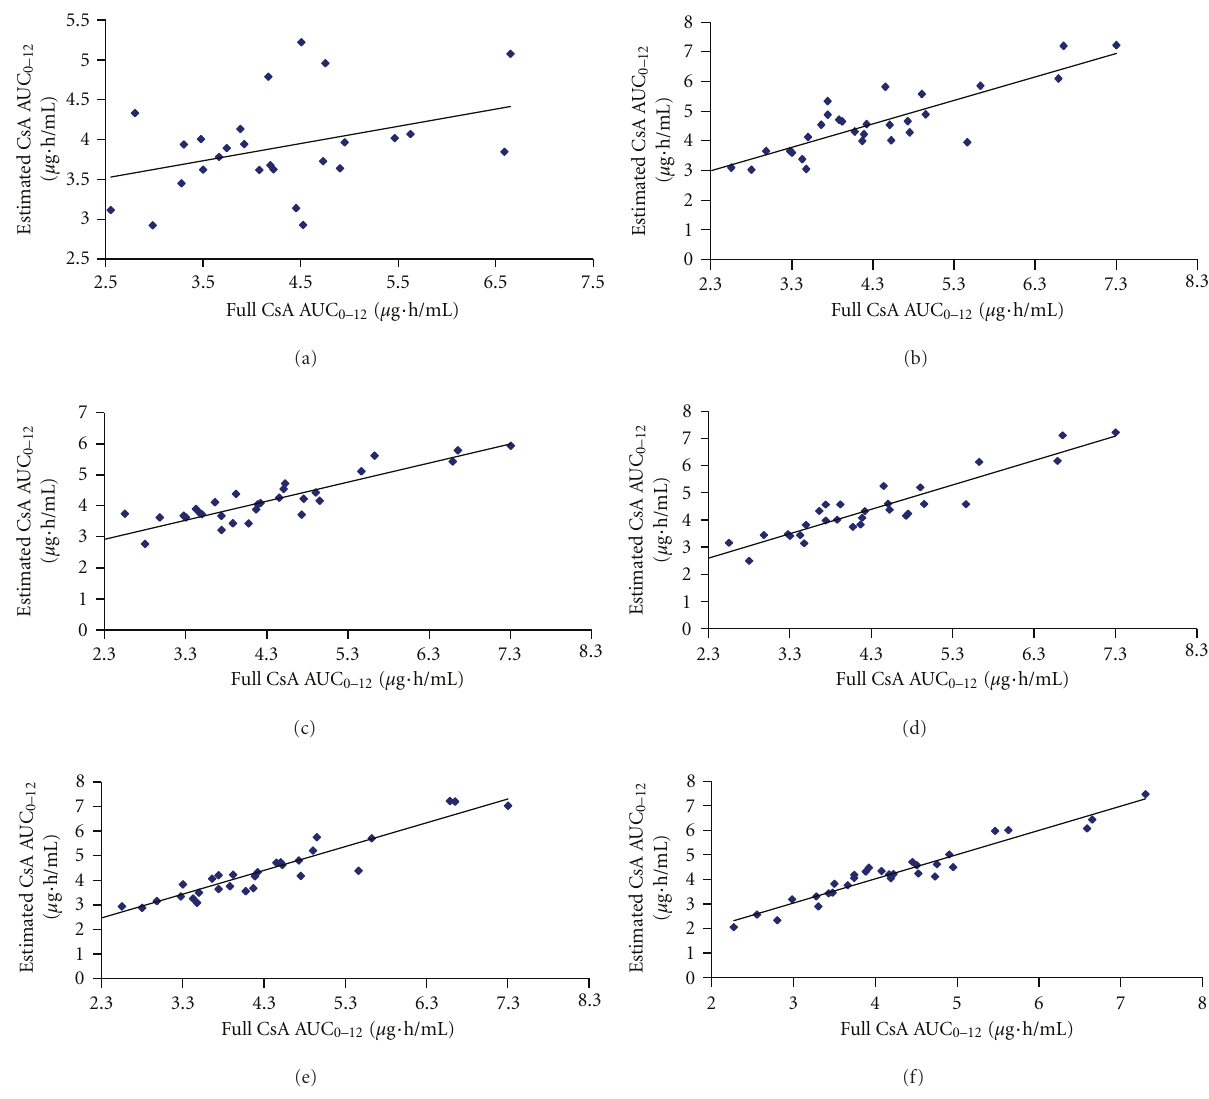
Figure 2: Comparison of the full cyclosporine (CsA) AUC 0–12h and values estimated using 6 regression models: (a) model using trough concentration ( R 2 = 0 . 391), (b) model using concentration at 2 hours after dosing ( R 2 = 0 . 848), (c) model using concentration at 4 hours after dosing ( R 2 = 0 . 897), (d) model using concentrations at 2 and 4 hours after dosing ( R 2 = 0 . 930), (e) model using concentrations at